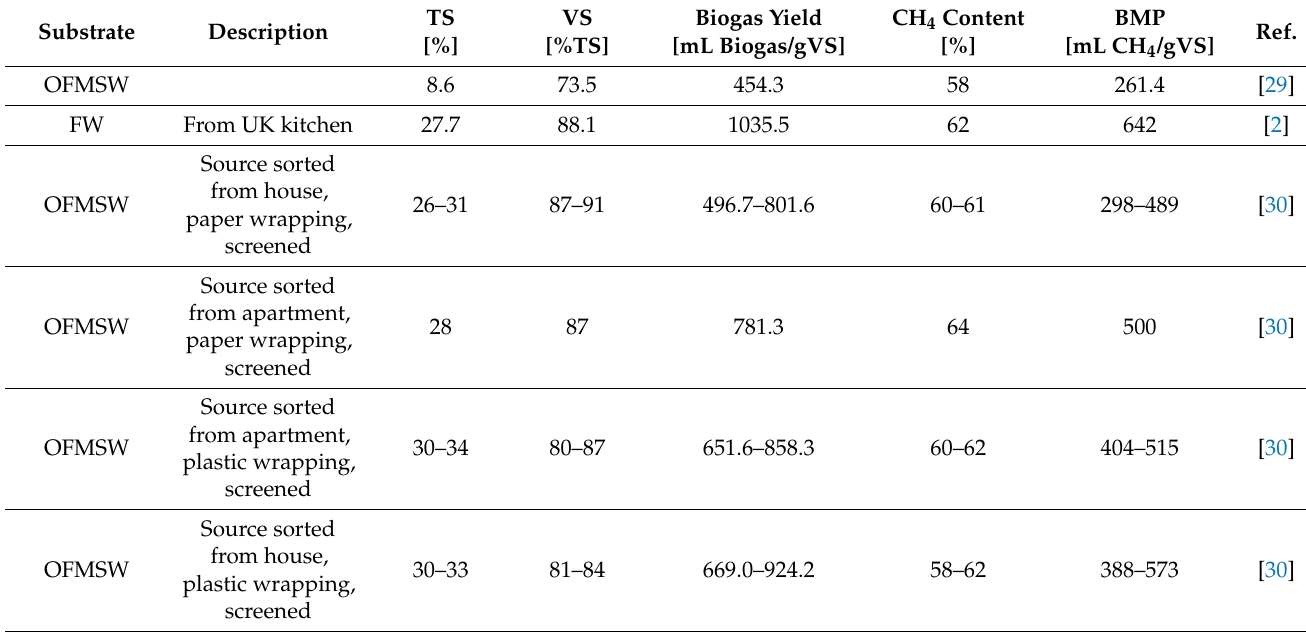
Table 3. Characterization of organic substrates present in the literature in terms of TS and VS content, biogas, methane yield, and methane